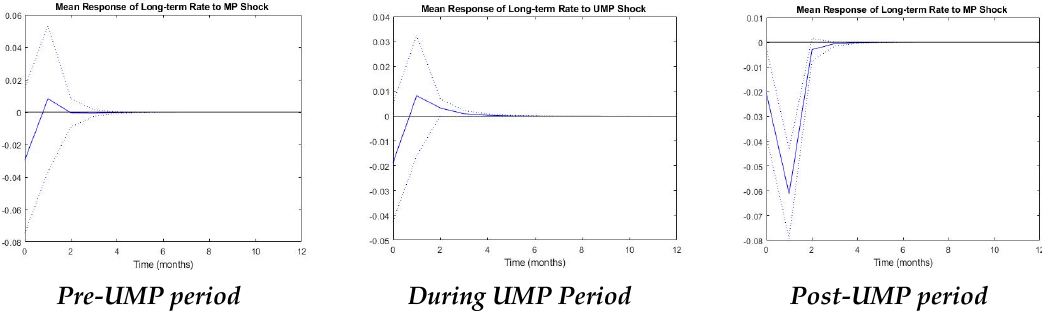
Figure 8. Mean responses of long-term interest rates in Asian developing economies to monetary policy shocks in pre-UMP, during UMP, and post-UMP periods .